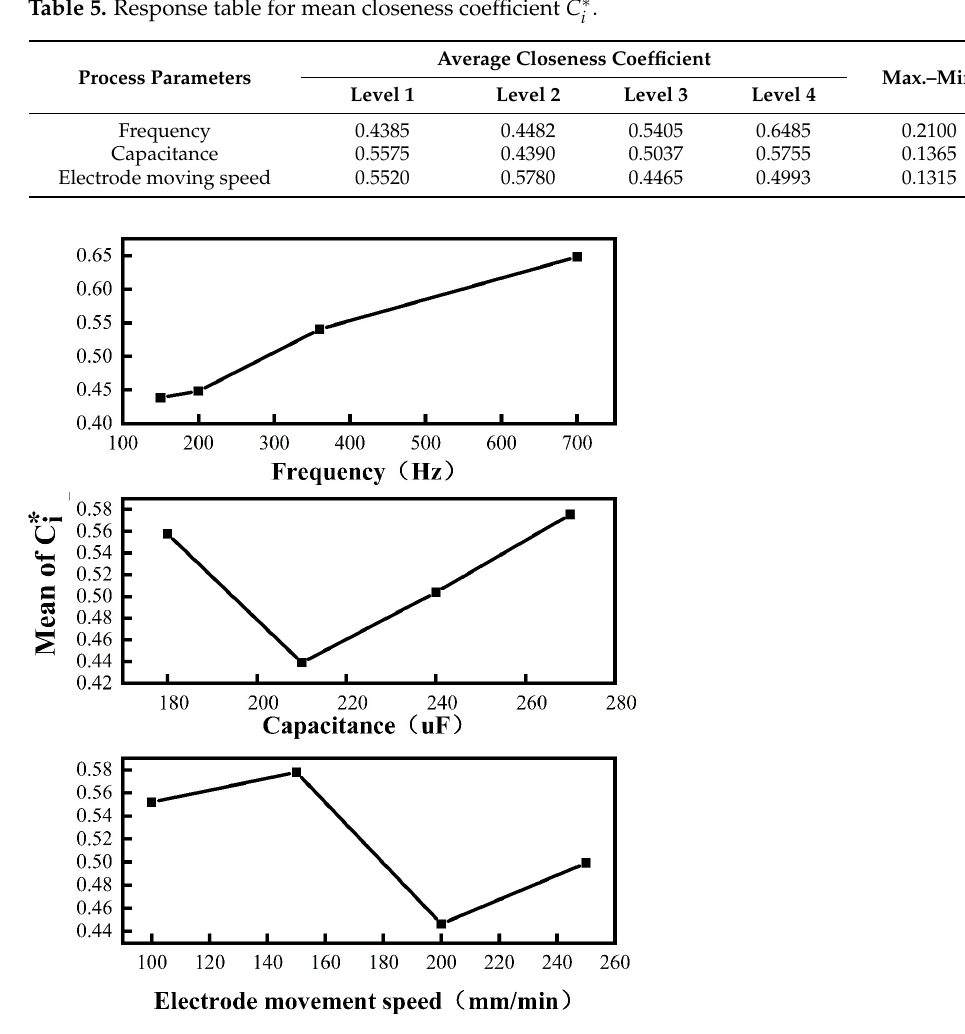
Table 5. Response table for mean closeness coefficient C ∗